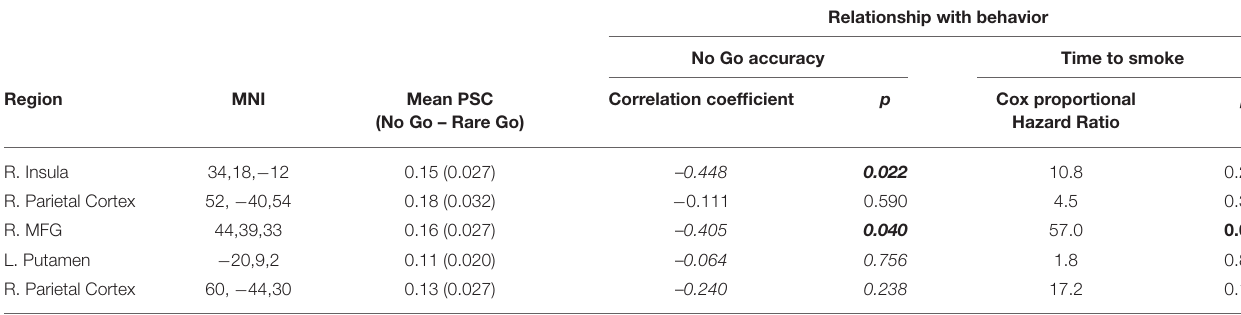
TABLE 4 | Relationship between abstinent IC-Activation and behavioral variables (whole brain